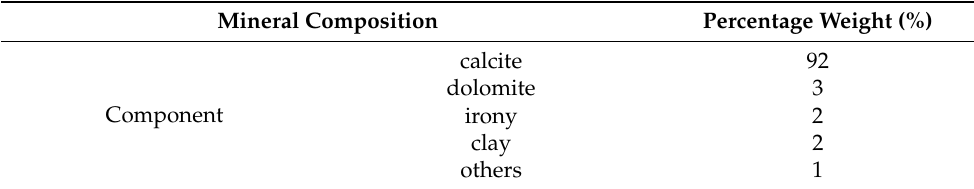
Table 1. Main mineral compositions of limestone samples.